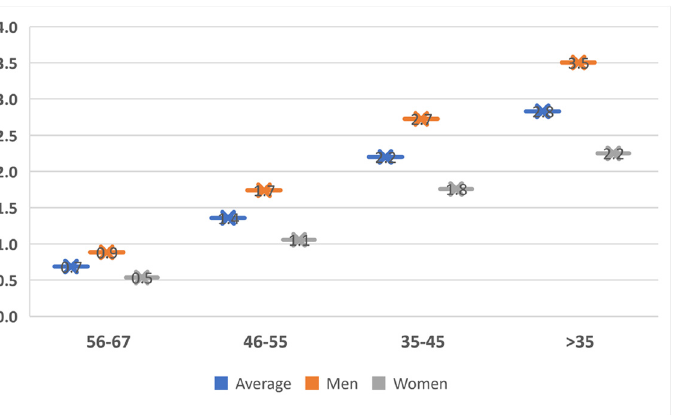
Figure 2. Expected Private Old-age Benefits in Terms of Forecast Periodical Poverty Line. Source: Authors’ calculations.